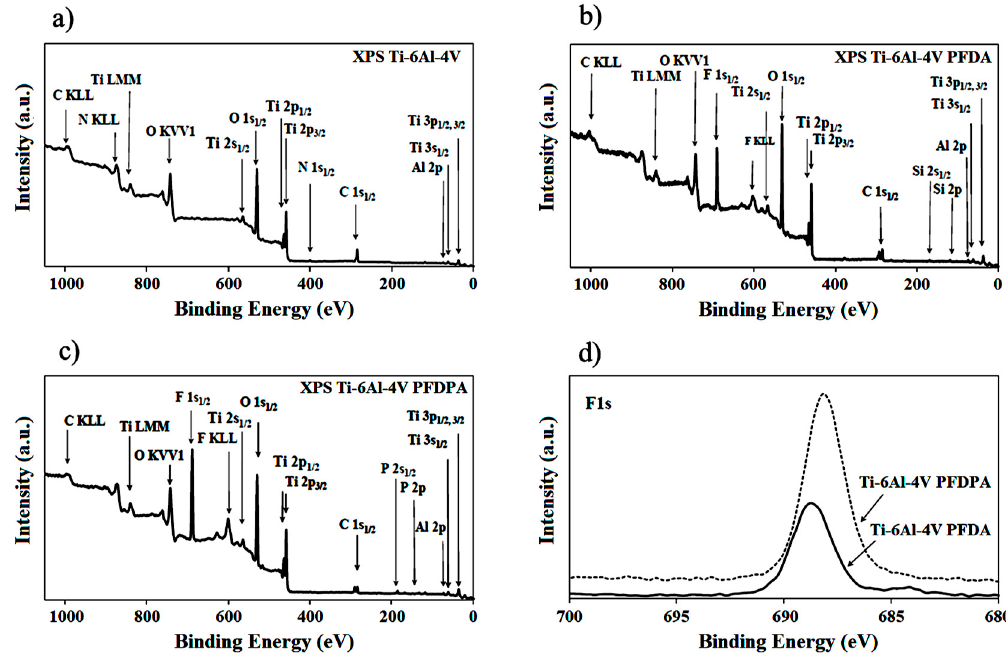
Figure 3. XPS spectra of the Ti-6Al-4V surface before and after modification: ( a ) Ti-6Al-4V substrate, ( b ) PFDA modification, ( c ) PFDPA modification, and ( d ) F 1s 1 / 2 peak of fluorine identified in both